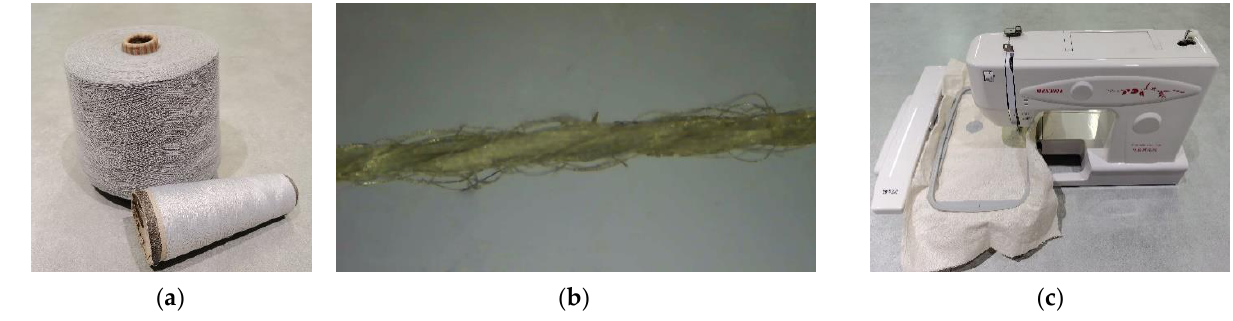
Figure 2. ( a ) Stainless steel blended yarn, ( b ) structure diagram of stainless steel blended yarn computerized and ( c ) embroidery